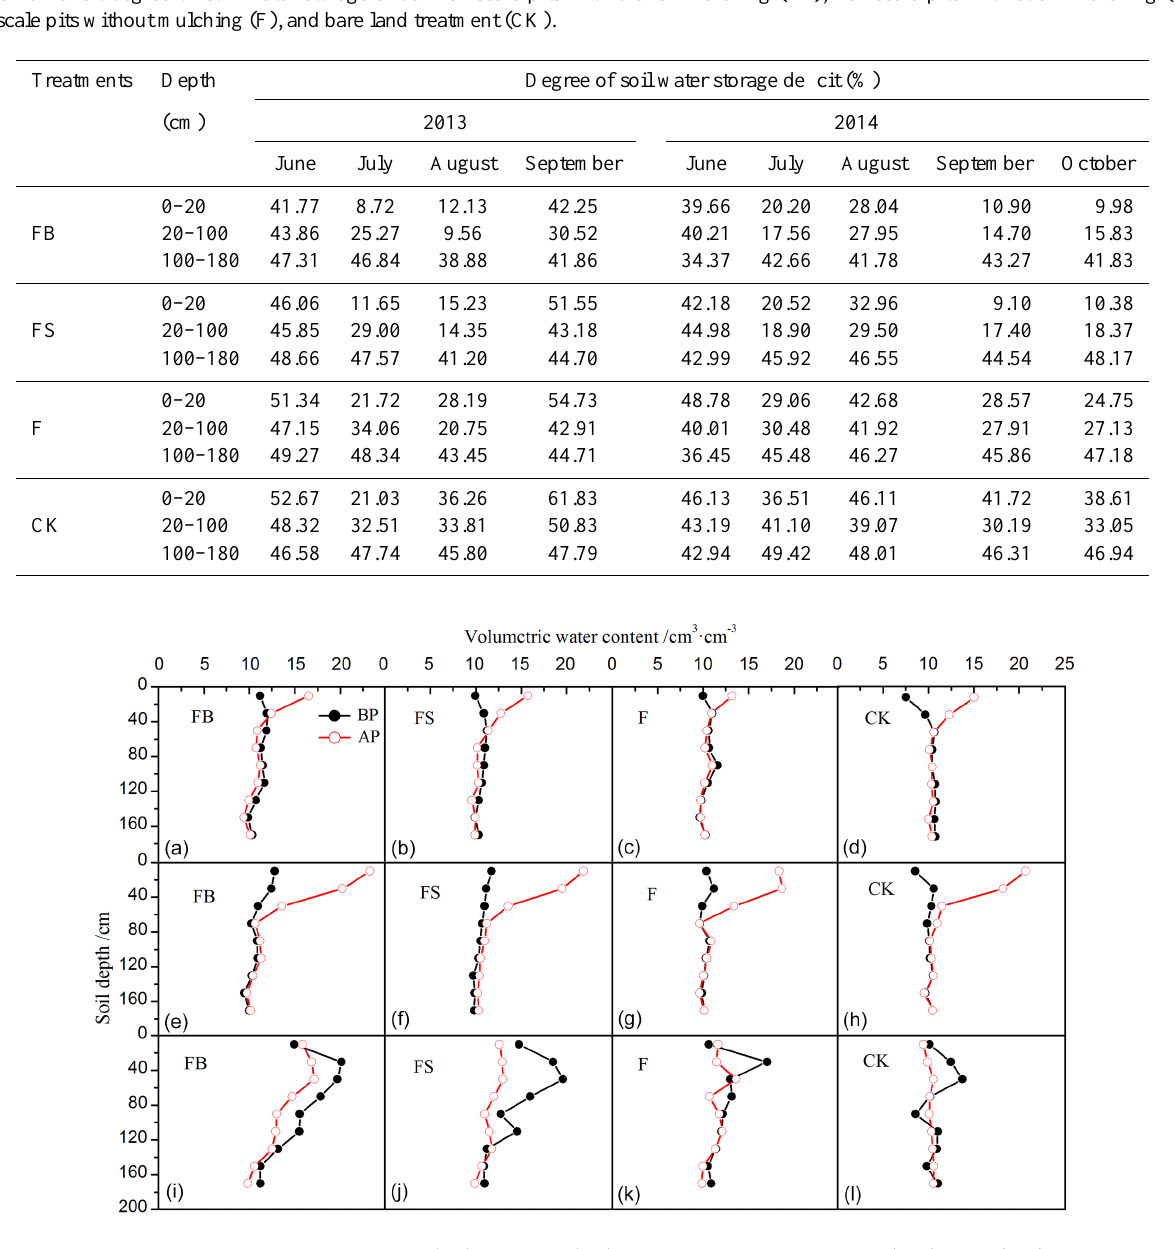
Figure 3. Vertical changes of soil moisture before (BF) and after (AP) typical precipitation in June (a–d) , July (e–h) , and August (i–l) under fish-scale pits with branch mulching (FB), fish-scale pits with straw mulching (FS), fish-scale pits without mulching (F), and bare land treatment